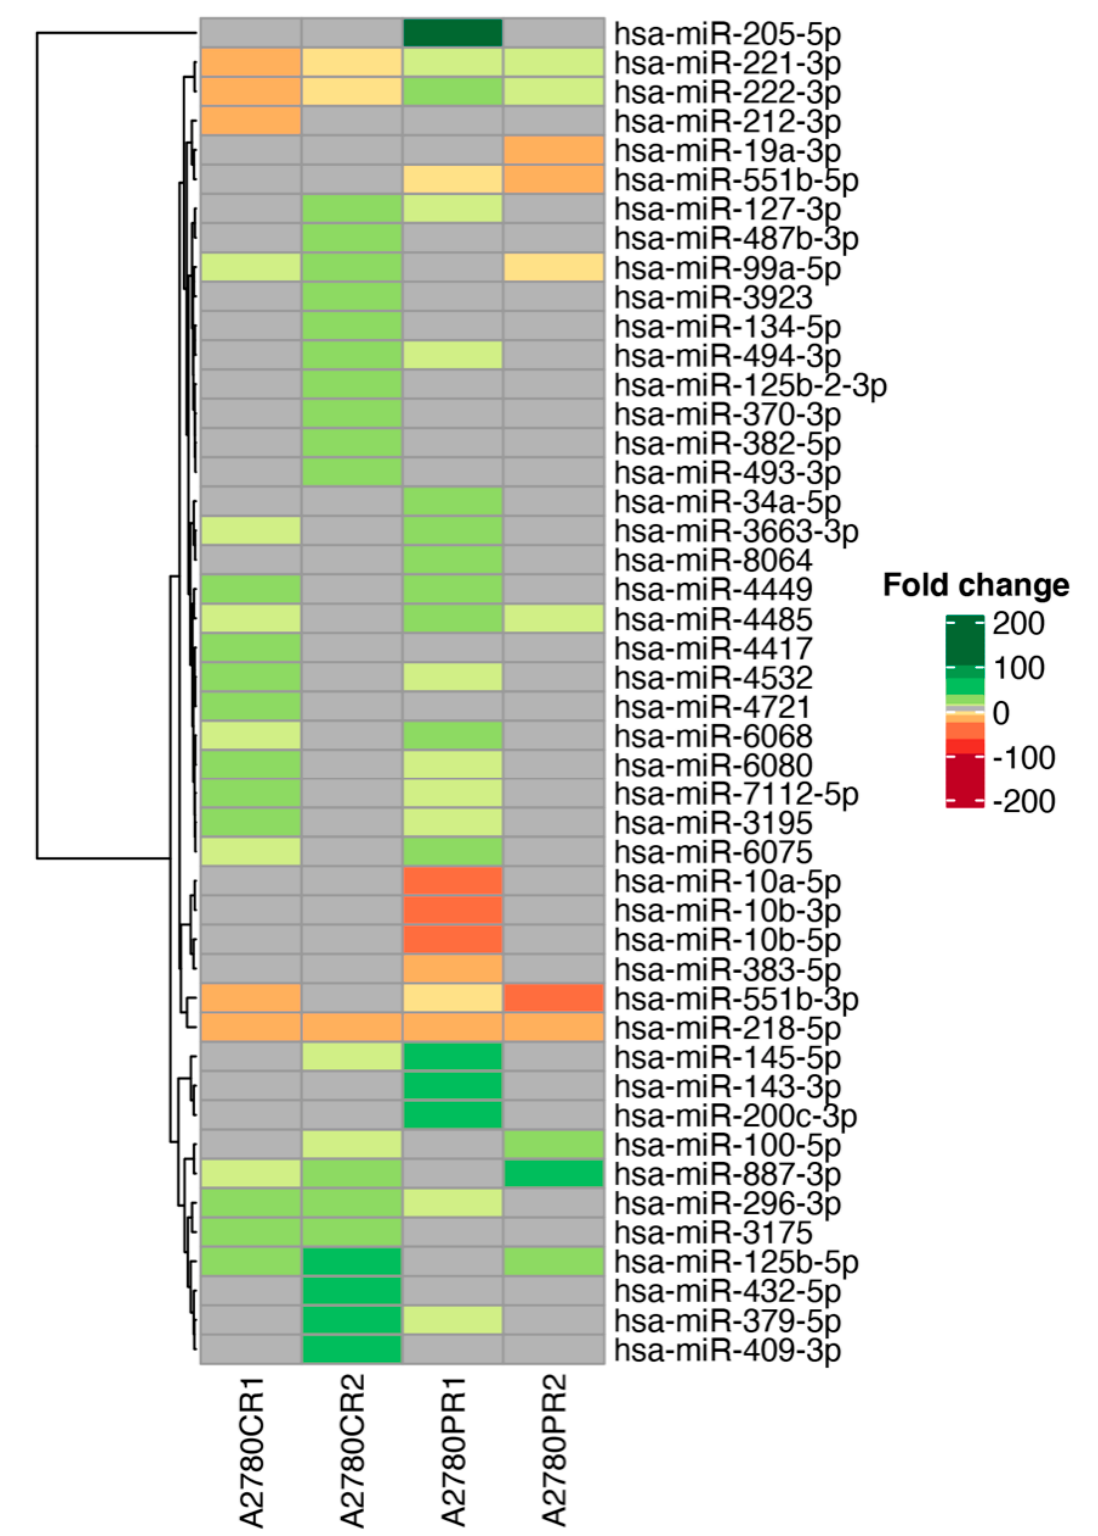
Figure 2. Expression ratios of miRNAs in drug-resistant sublines.